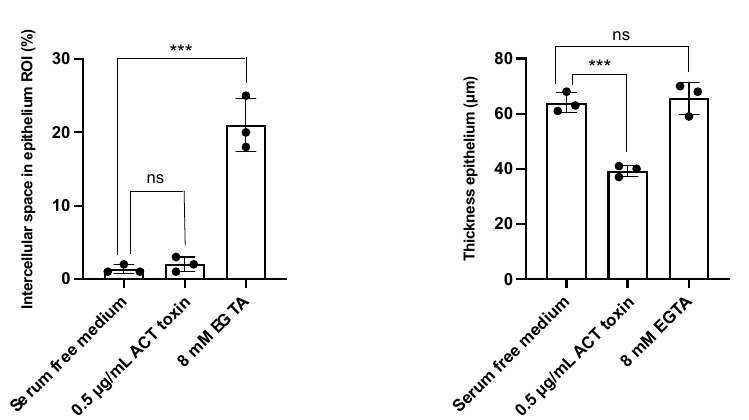
Figure 1. Treatment with the Hla and ACT toxins causes morphological changes in equine respiratory mucosa. ( A ) Effect of the Hla toxin on the morphology of equine respiratory mucosa. Hematoxylin- eosin (HE) stainings of paraffin-embedded sections of respiratory mucosal explants treated with Hla toxin or serum-free medium ( upper panel). Central tendencies for intercellular space and epithelial thickness are indicated by the left and right bar plots, respectively ( lower panel). ( B ) Effect of the